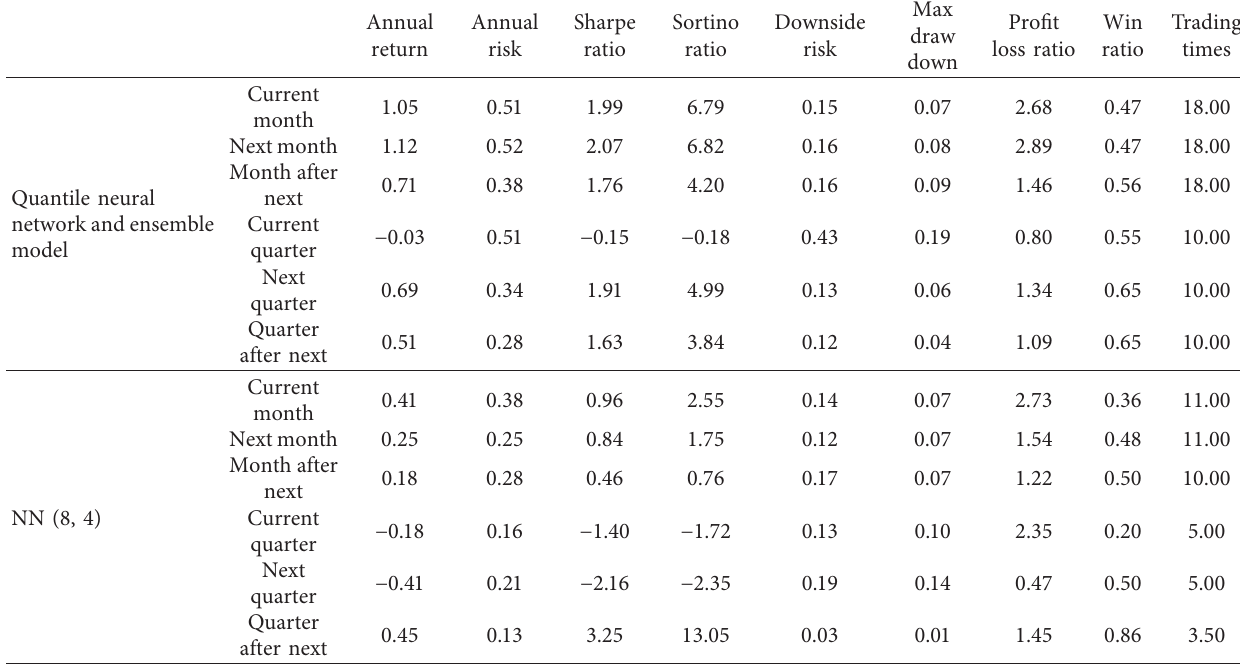
Table 24: Option strategy of volatility prediction with dynamic thresholds based on quantile neural network and model integration algorithm.